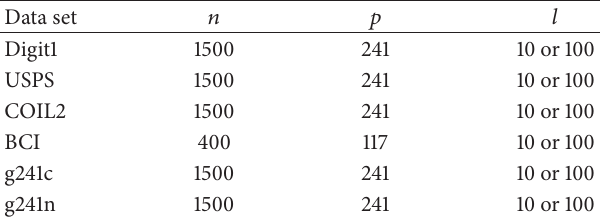
Table 3: Data sets used in the experiments. 𝑛 , 𝑝 , and 𝑙 are the number of samples, features, and labeled samples,